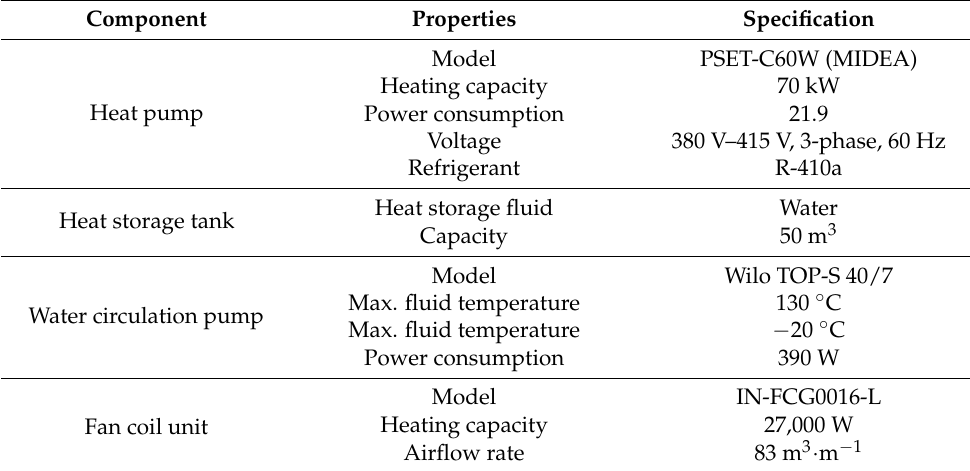
Table 2. Specification of the